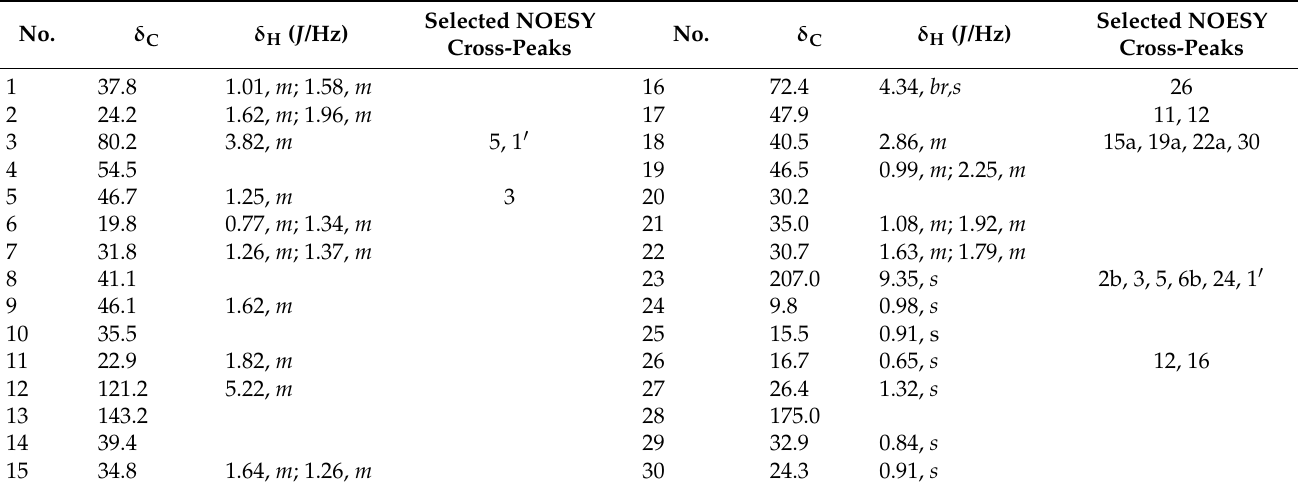
Table 1. 1 H and 13 C NMR chemical shifts of the aglycone part of compound 1 (DMSO-d 6 , δ /ppm, J /Hz, and 400 MHz) and selected NOESY